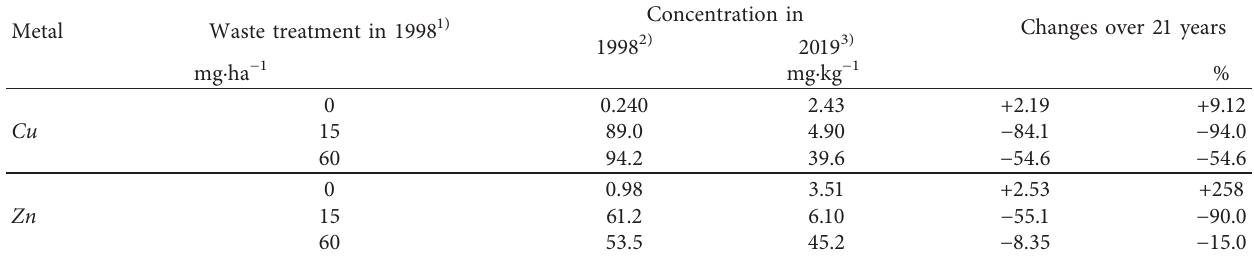
Table 6: The changes in the concentrations of Cu and Zn in soil over 21 years from 1998 to 2019. Concentration Metal Waste treatment in 1998 1)